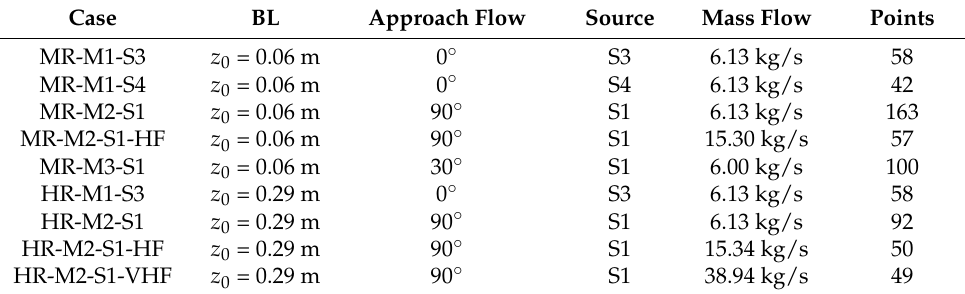
Table 3. Case definition for the heavy gas